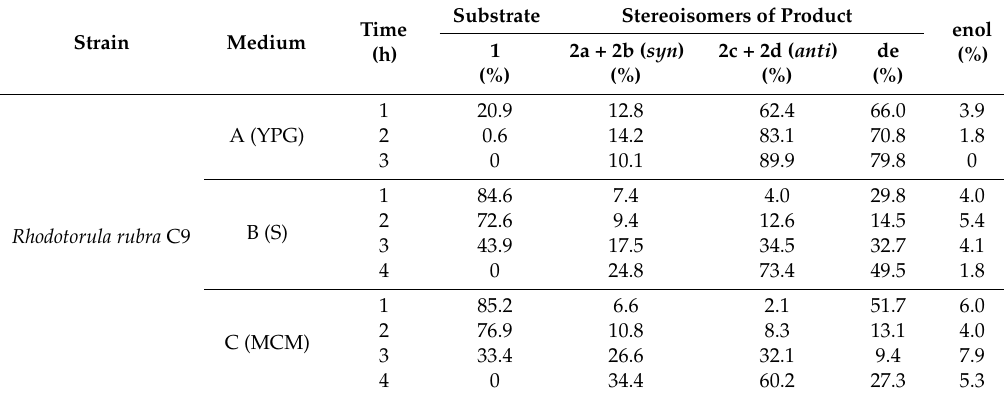
Table 3. The results of biotransformation of α -acetylbutyrolactone 1 by R. rubra C9 in different media (in % according to GC (chiral column)).